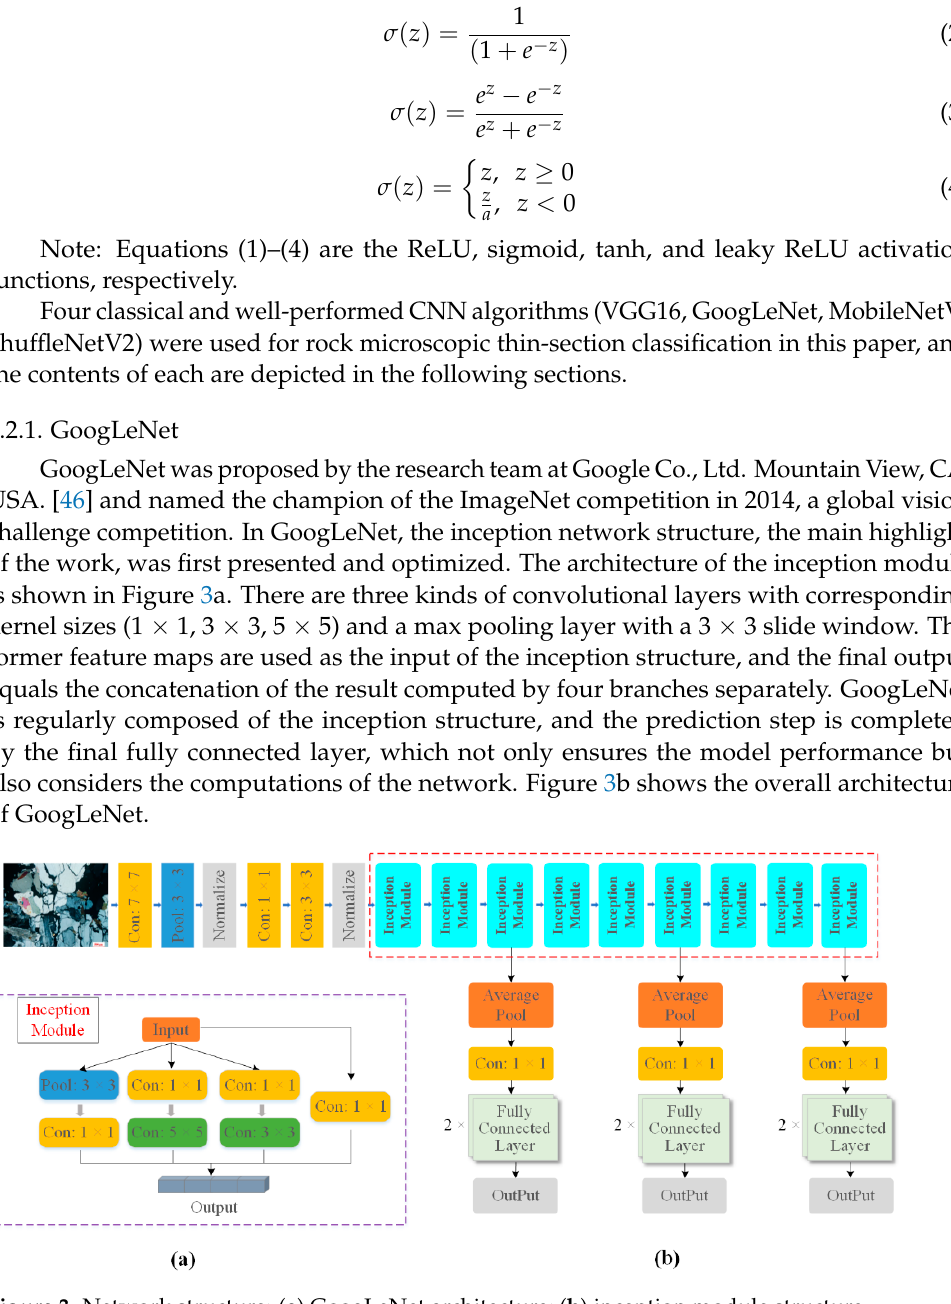
Figure 3. Network structure: ( a ) GoogLeNet architecture; ( b ) inception module structure.